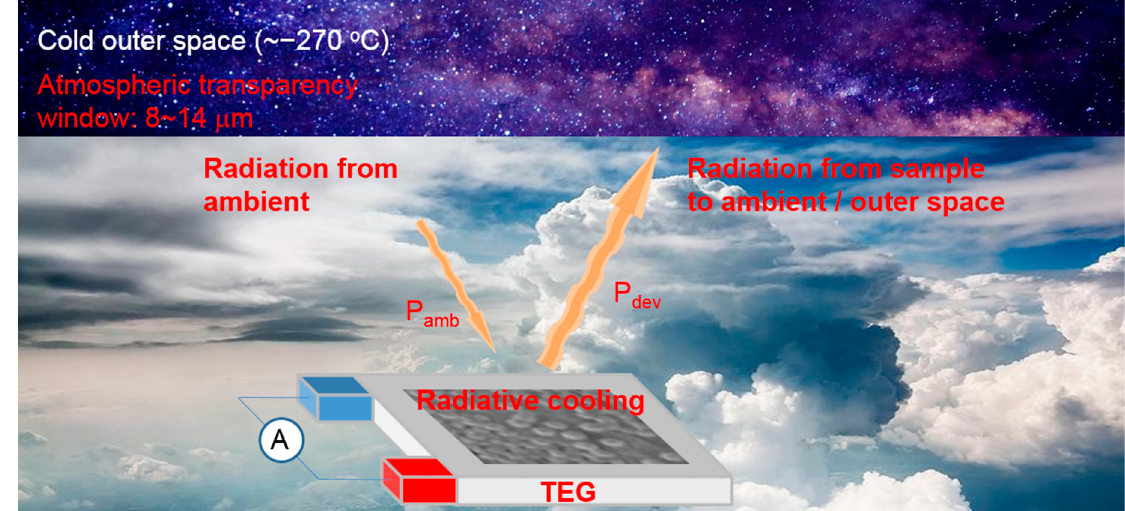
Figure 1. Conceptual schematic of the proposed device for harvesting ambient energy via passive radiative cooling